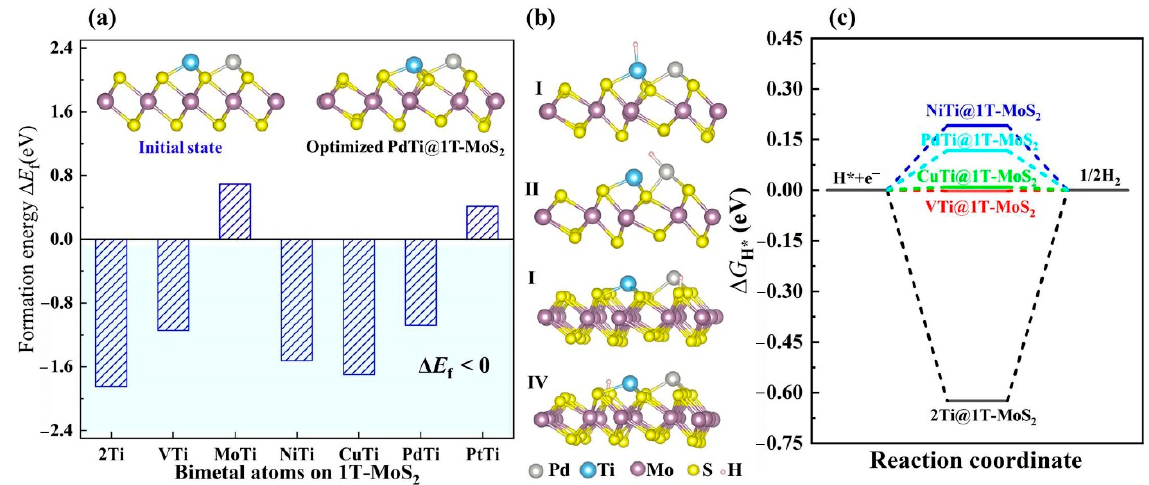
Figure 5. ( a ) Formation energy of TMTi@1T-MoS 2 hybrids by anchoring bimetal atoms on the 1T-MoS 2 surface, where the insets show the initial state and optimized equilibrium structure of PdTi@1T-MoS 2 as an example. ( b ) Side views of the considered H* adsorption sites on PdTi@1T-MoS 2 . ( c ) Δ G H* of H* on the lowest energy state for a given bimetal catalyst.